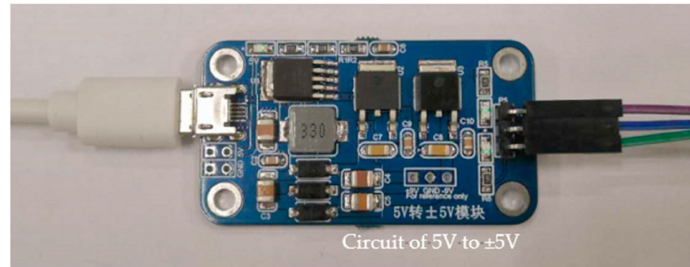
Figure 11. A prototype of circuit.